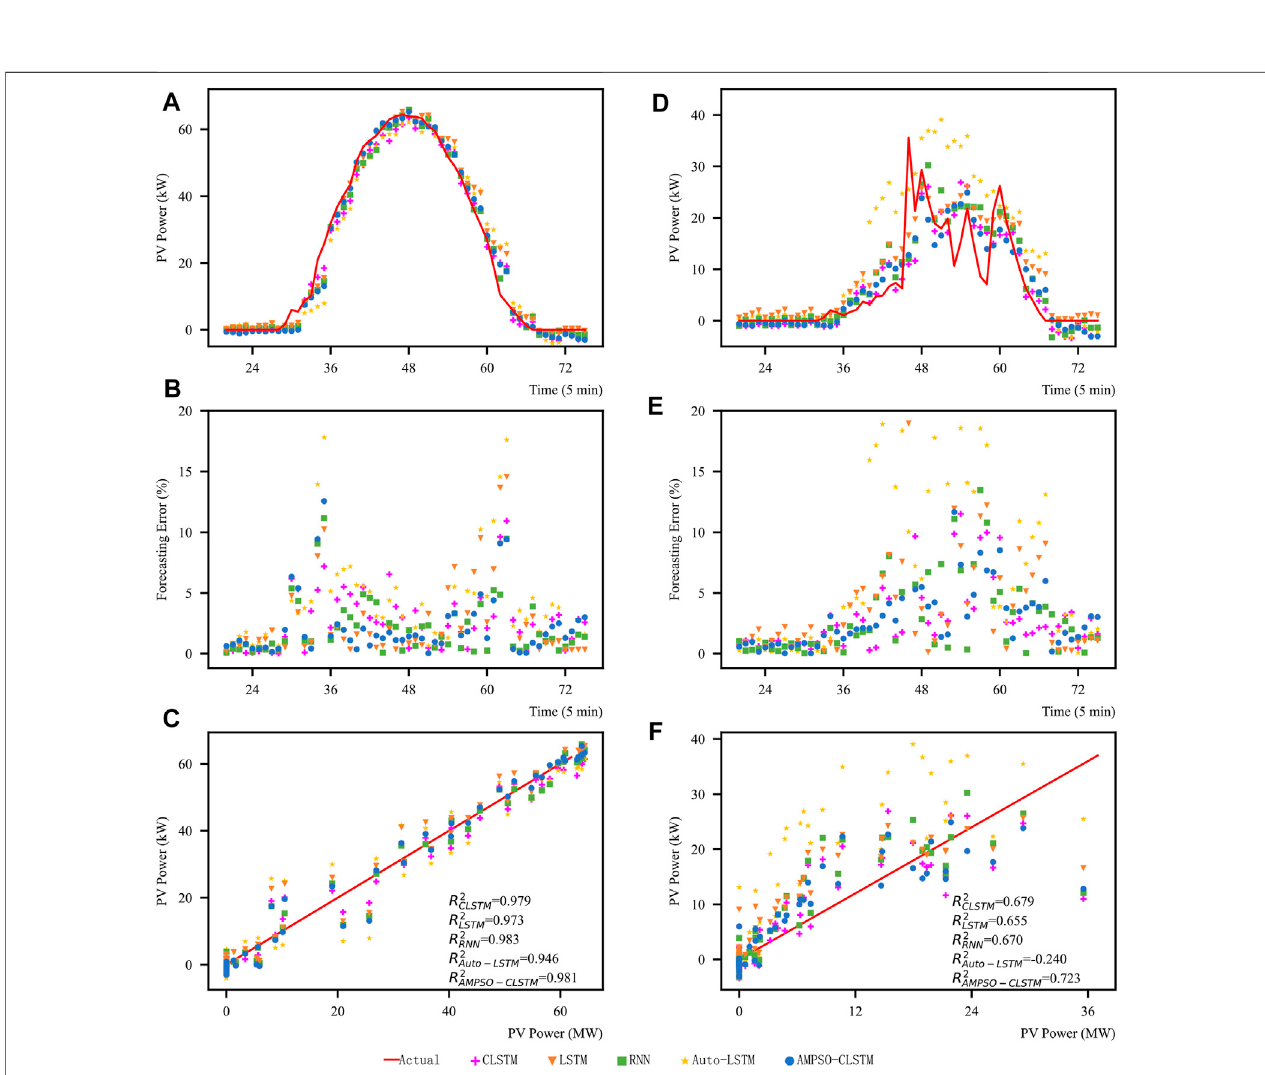
FIGURE9| ForecastingresultanalysisforTaiyangshanonasunnydayandarainyday. (A,D) aretheforecastingresultsforTaiyangshanonasunnydayandarainy day. (B,E) are the forecasting error of all models on a sunny day and a rainy day. (C,F) plot the regression analyses for the sunny and rainy day.